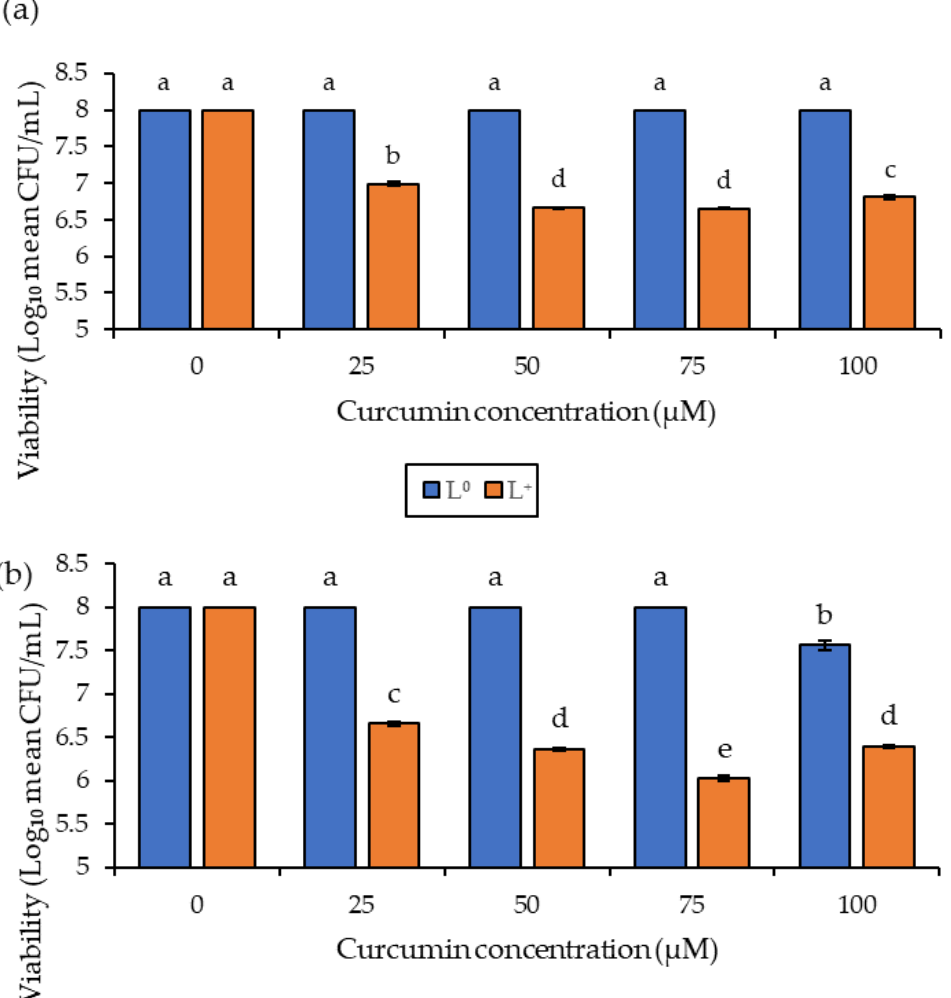
Figure 1. Effect of photosensitization on the viability of Aspergillus flavus spores using different curcumin concentrations after light dosage treatment of ( a ) 76.4 J/cm 2 , and ( b ) 114.5 J/cm 2 at 420 nm. Different letters indicate statistically significant differences ( p < 0.05) between treatments; n = 3 independent experiments with triplicate samples per condition per experiment.